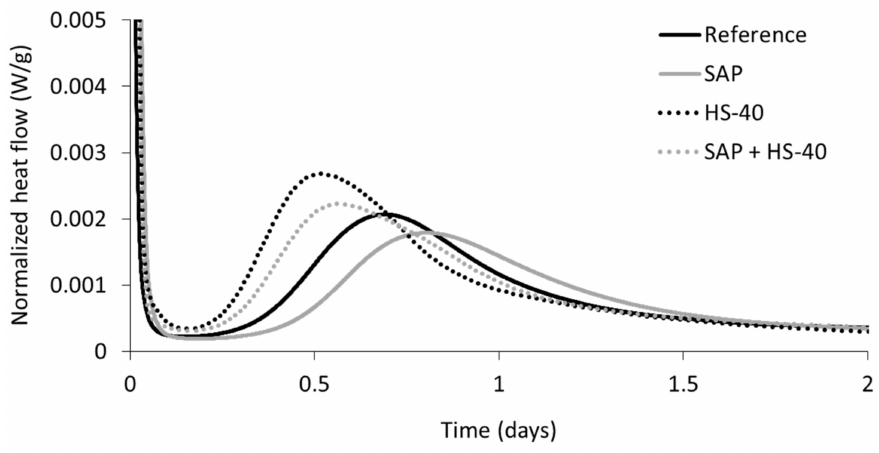
Figure 3. Normalized heat flow versus time of cement